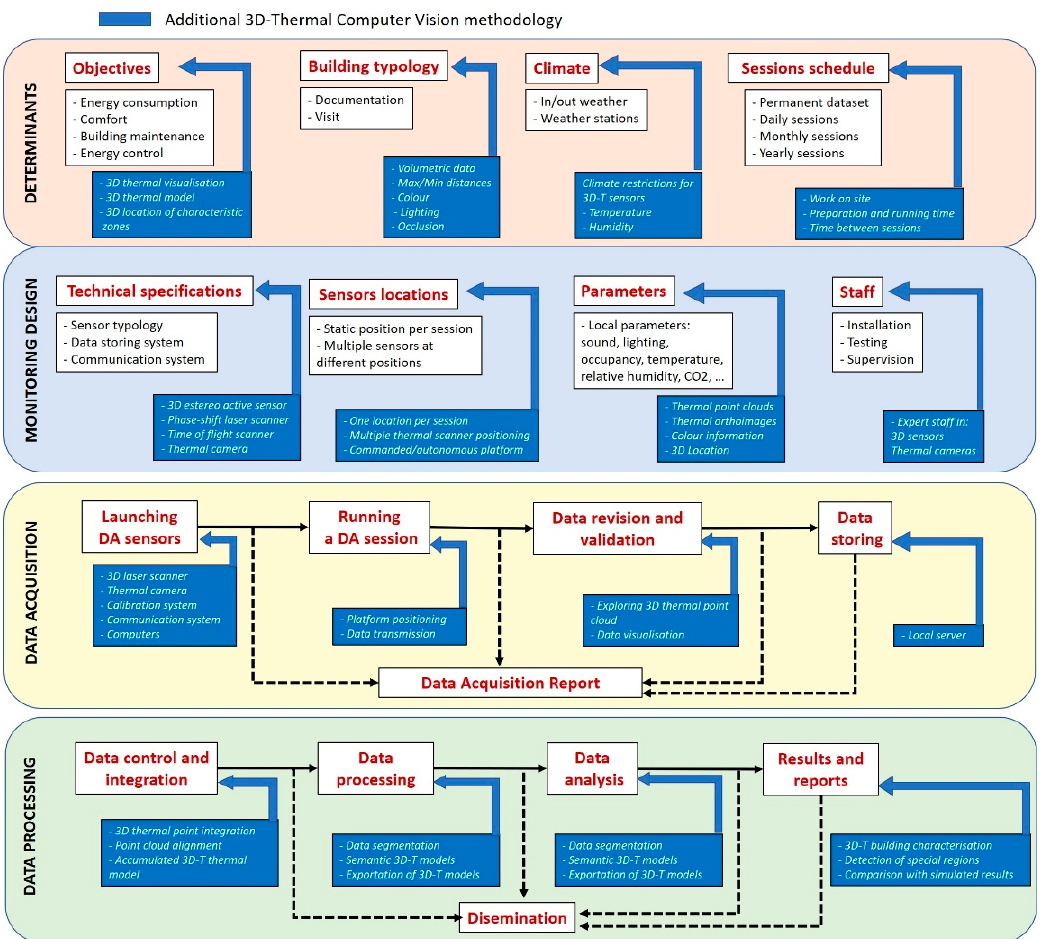
Figure 1. General building monitoring methodology extended to thermal computer vision-based (3D-TCV) technologies.